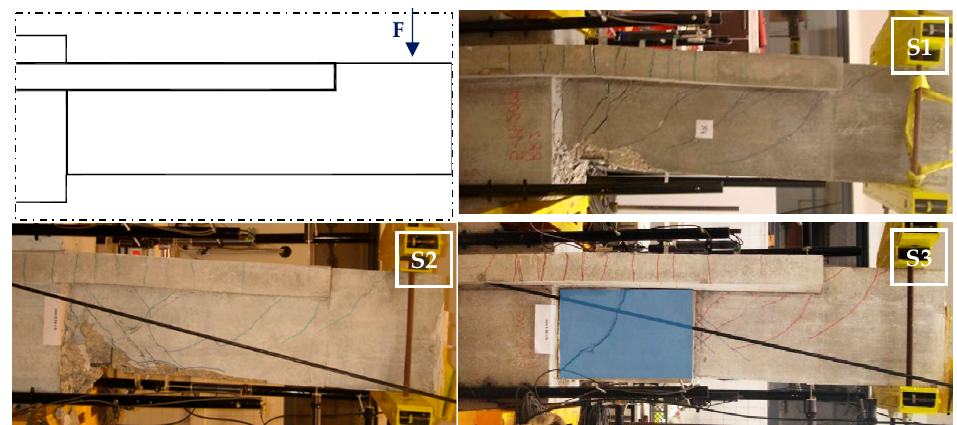
Figure 6. Specimens S1, S2, and S3 failure modes—lateral elevation.